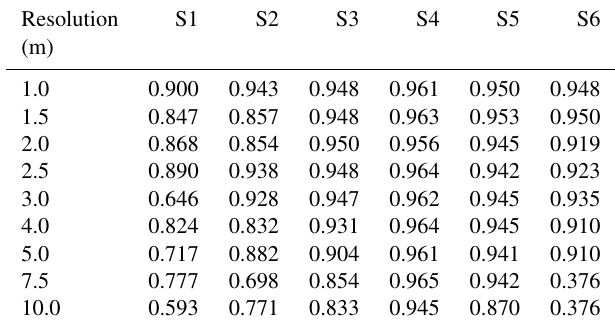
Table A4. Table of accuracy for sites S1 to S6 (columns) with a Wiener filter, for resolutions varying between 1 and 10m (rows).